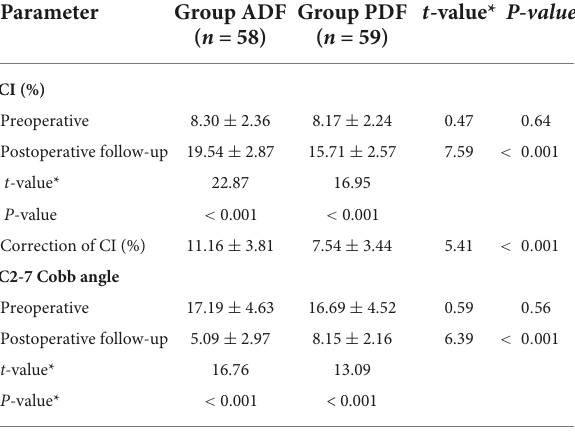
TABLE 3 PreOP and PostOP follow-up Japanese Orthopedic Association (JOA) score and neurological recovery rate in each